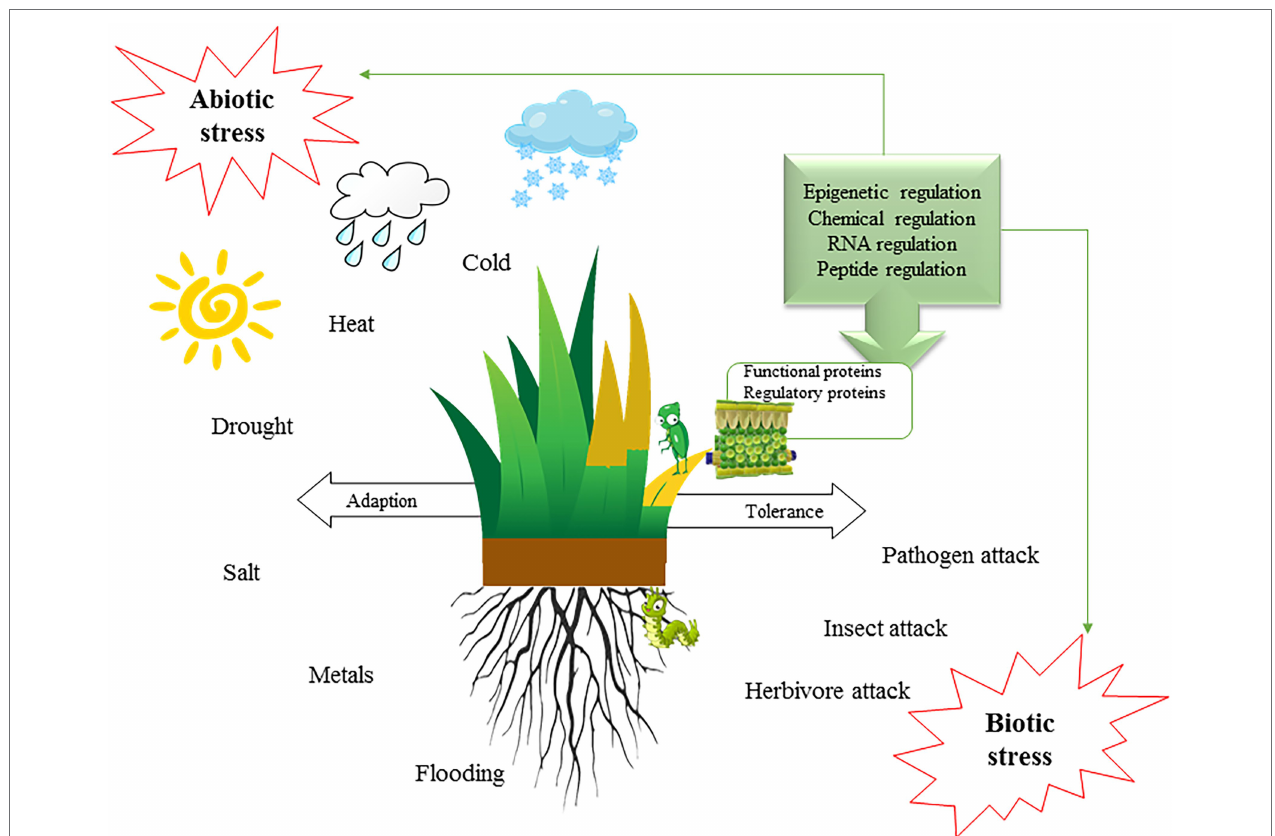
FIGURE 2 | Tolerance and response to environmental stress in